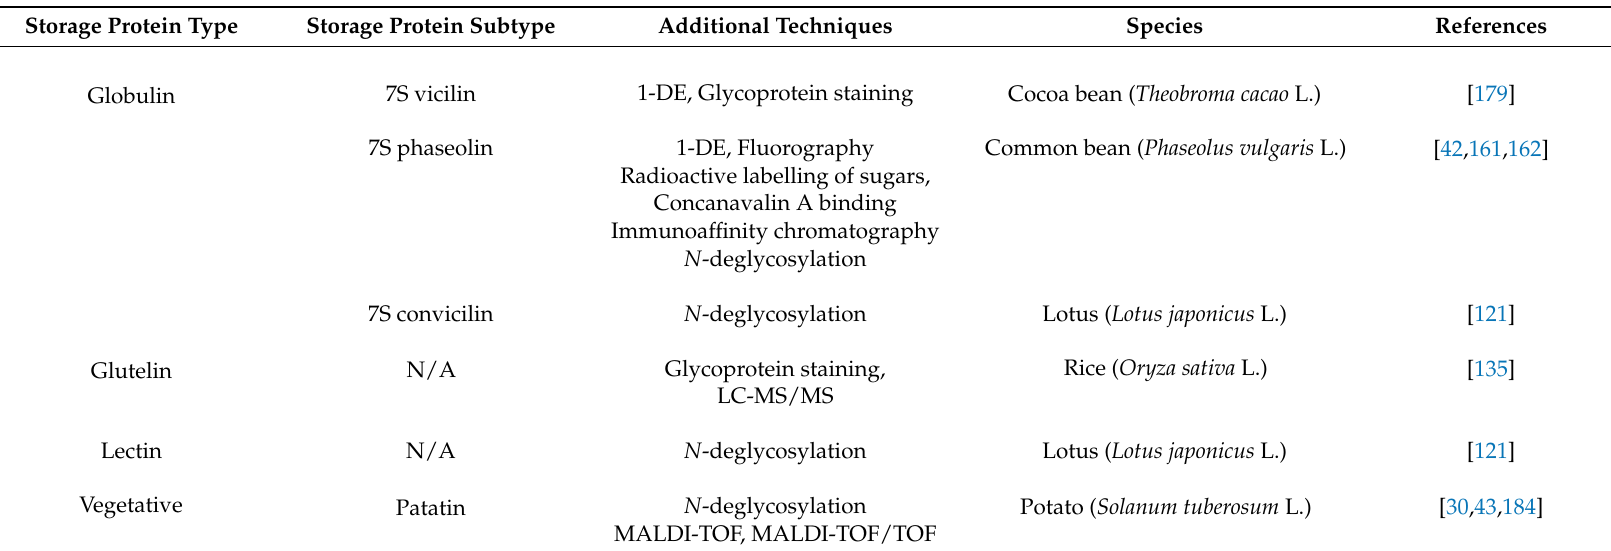
Table 3. List of 2-DE-based seed glycoproteomic studies including storage